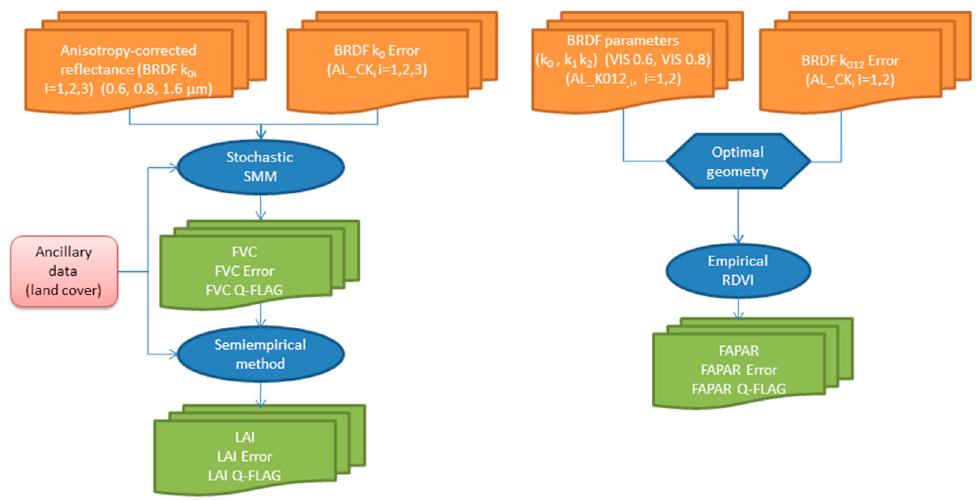
Figure 1. Flow chart of the algorithm for FVC, LAI and FAPAR determination.